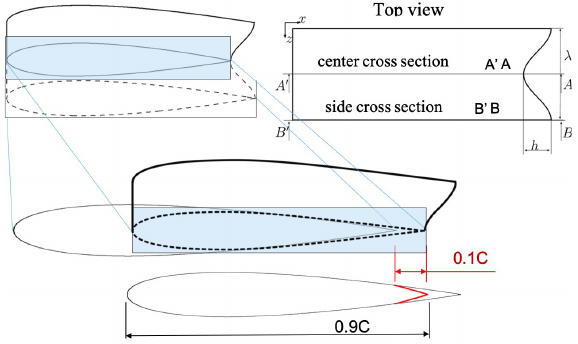
Figure 1. Sketch configuration of the serrated